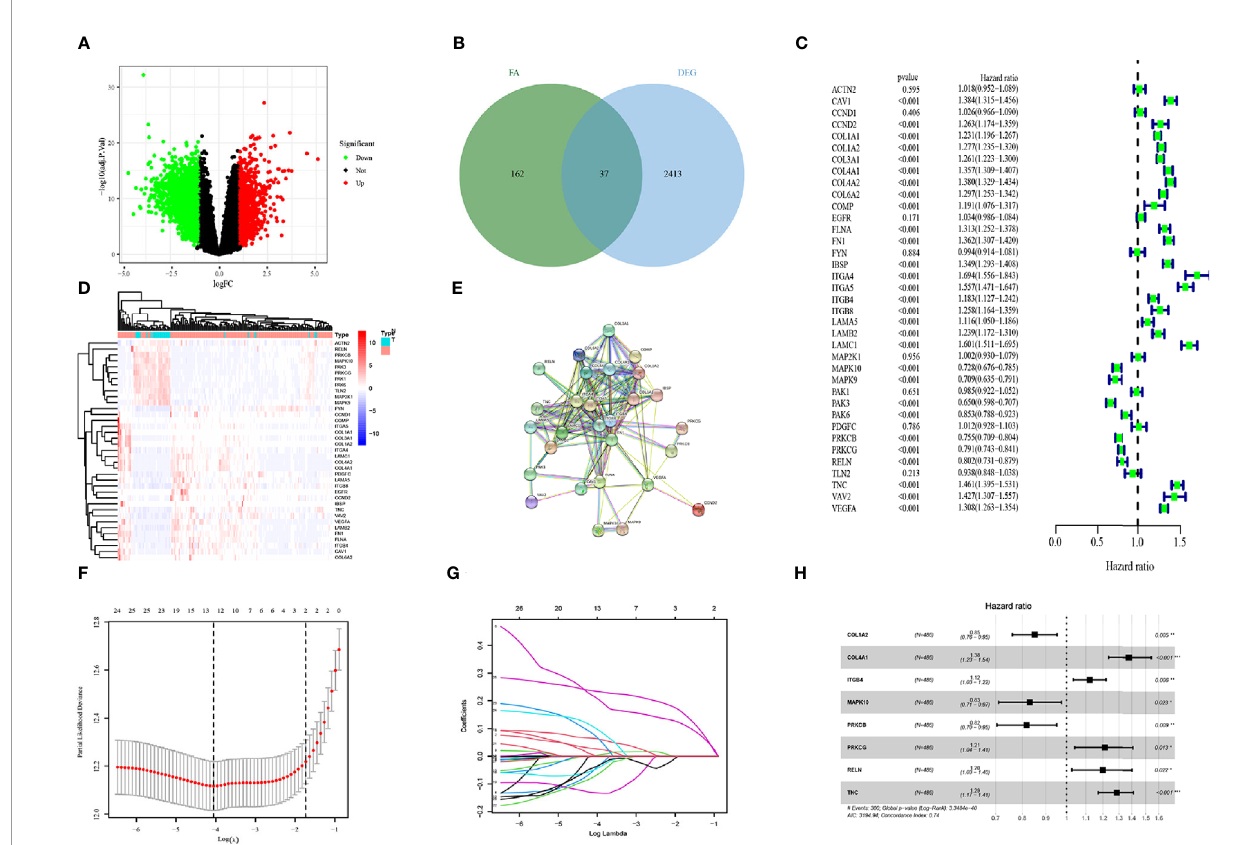
FIGURE 2 | Identi fi cation of candidate genes and LASSO-COX analysis (A) Volcano plot of differentially expressed genes in glioma from the GEO database. (B) Heatmap of differentially expressed genes in glioma from the GEO database. (C) Univariate regression analysis of FADGs. (D) Venn plot of differentially expressed genes and focal adhesion related genes. (E) Protein-protein interacting network. (F, G) Construction and validation of focal adhesion related signature. (H) Multivariate cox regression analysis of eight candidate